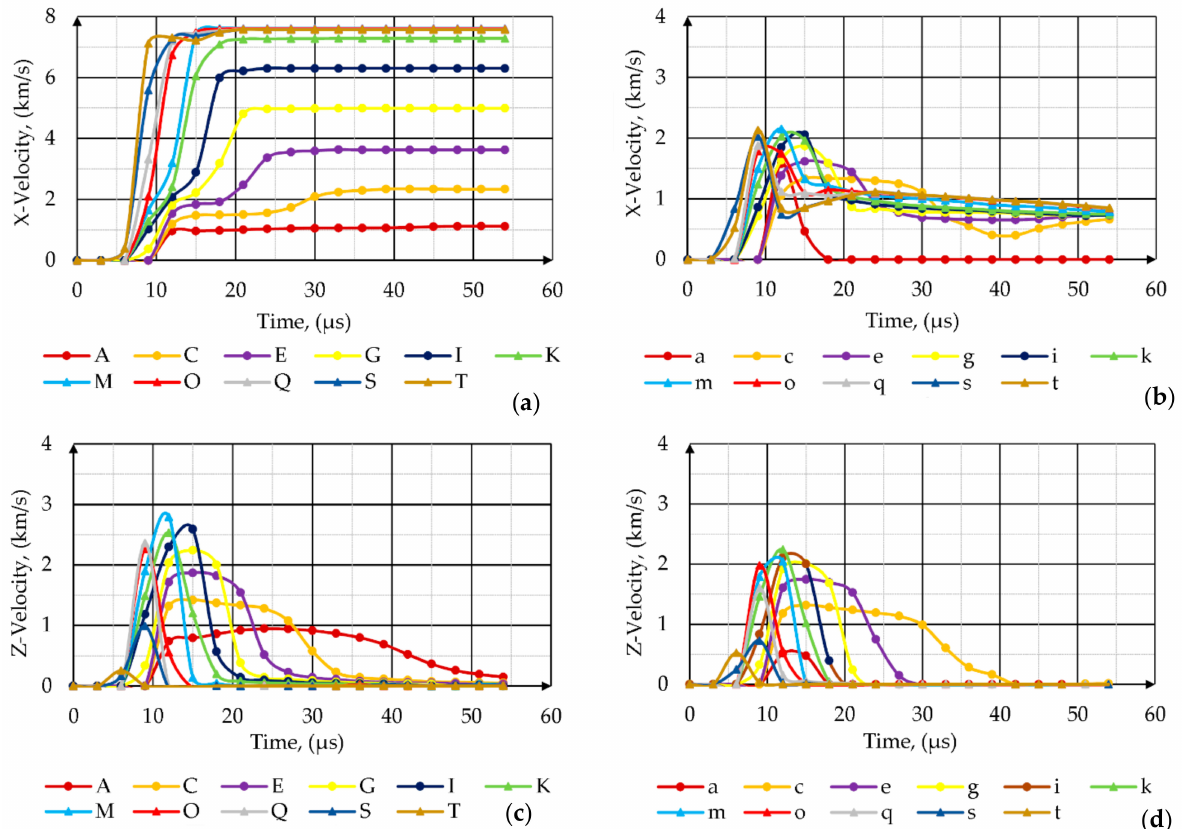
Figure 14. Axial velocities of tracer points initially located on the ( a ) inner and ( b ) outer surface of the liner. Radial velocities of tracer points initially located on the ( c ) inner and ( d ) outer surface of the